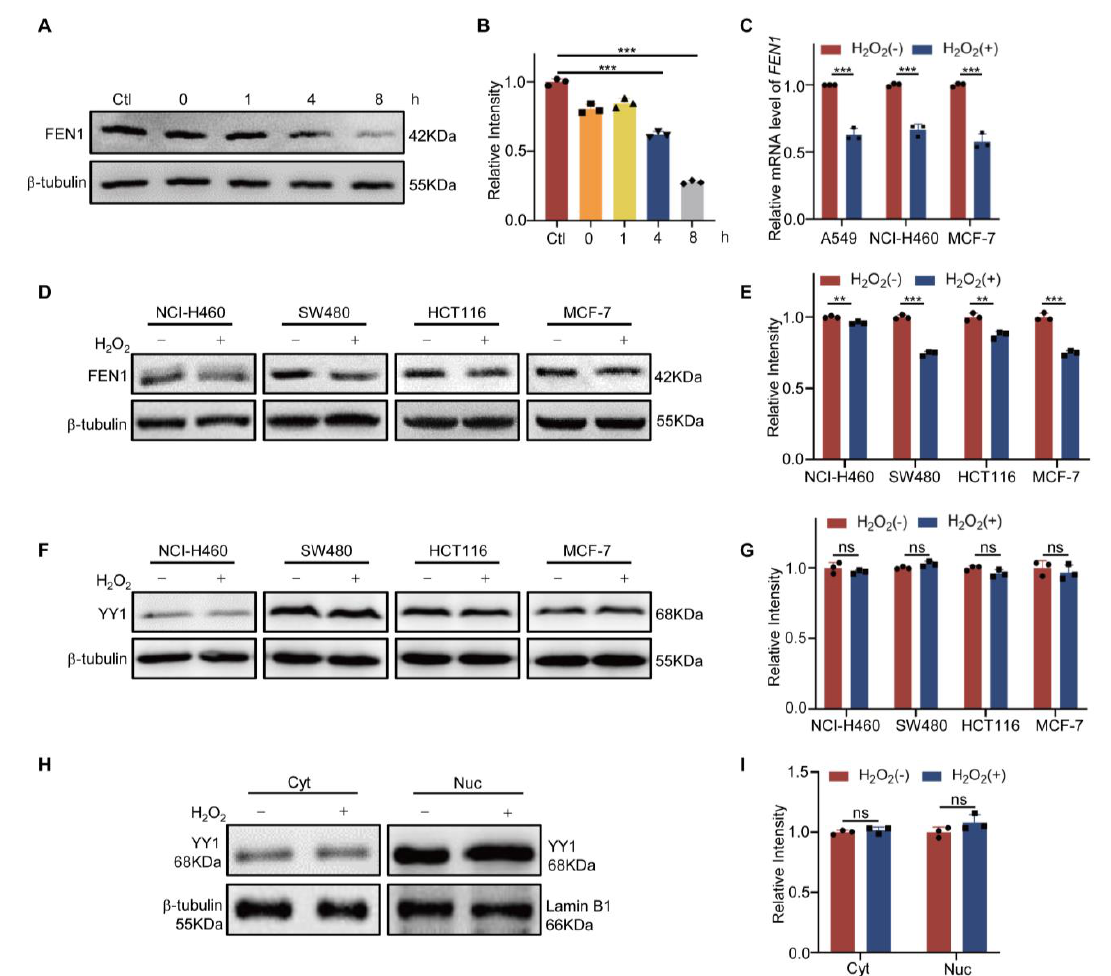
Figure 1. FEN1 is downregulated under oxidative stress. ( A ) Western blot detected the FEN1 protein level of MCF − 7 cells recovered at different time points after 300 M H 2 O 2 treatment for 2 h. − tubulin was used as an internal control. ( B ) Quantification of the marks shown in the panel ( A ). ( C ) A549, NCI − H460 and MCF − 7 cells were treated with 300 M H 2 O 2 for 2 h and then recovered for 4 h. RT − qPCR was used to measure FEN1 mRNA level and − actin was used as a loading control. ( D ) NCI − H460, HCT116, MCF − 7 and SW480 cells were treated as in ( C ). Western blot was used to measure FEN1 protein levels and − tubulin was used as a loading control. ( E ) Quantification of the marks shown in the panel ( D ). ( F ) After the cells were treated as in panel ( C ), the protein level of YY1 was detected by Western blot. ( G ) Quantification of YY1 levels in ( F ). ( H ) Nucleocytoplasmic separation assay was used to detect the intracellular distribution of YY1 under oxidative stress. − tubulin was used as an internal reference for cytoplasm, and Lamin B1 was used as an internal reference for the nucleus. ( I ) Quantitative analysis of panel ( H ). The data represent the mean ± SD of three independent experiments. Student’s t − test, ** p < 0.01; *** p < 0.001; ns, no significance.